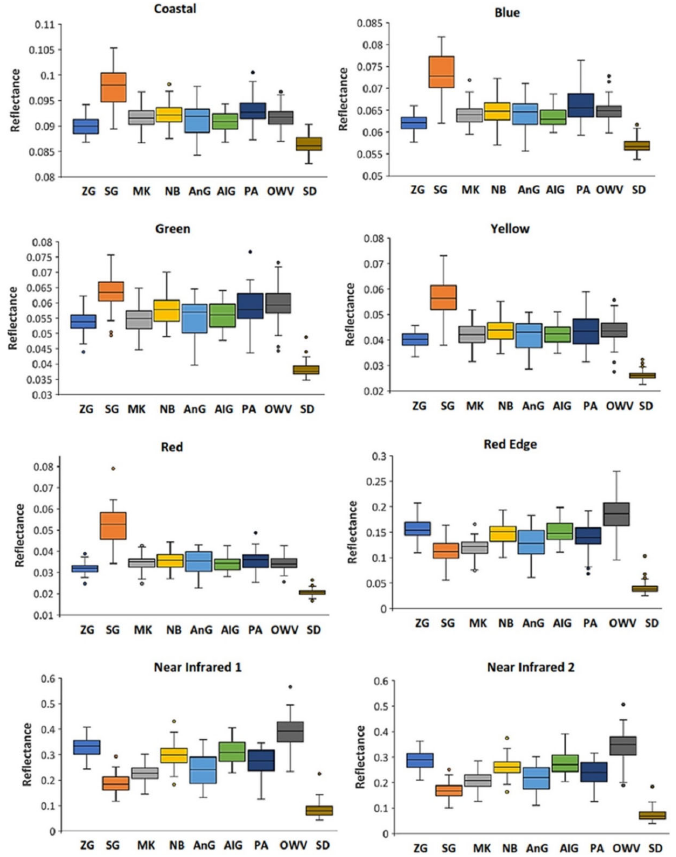
Figure 4. Box ‐ whisker plots showing tree species mean reflectance values derived from WorldView ‐ 2 data. The central lines within each box represent the medians, while the top and bottom edges of the boxes are the upper and lower quar ‐ tiles, respectively. The dots represent the outlier values within tree species. Full species names for each species code are given in Table 1. Table 2 is a matrix showing the inter ‐ specific spectral separability of the tree species calculated from the WorldView ‐ 2 VNIR bands using the JM distance. The highest JM dis ‐ tances were reported for Syzygium guineense , i.e., values greater than 1. The lowest values were 0.42 for separability between Newtonia buchananii and Albizzia gummifera , and 0.43 for Newtonia buchananii and Anthocleista grandiflora . The highest values are shown in bold.